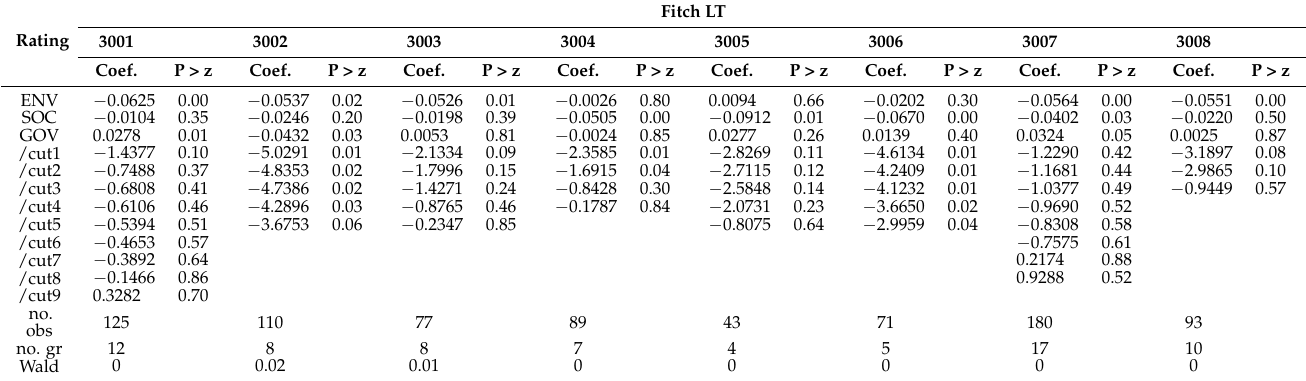
Table 7. Impact of the ESG measures on Fitch long-term issuer credit ratings by